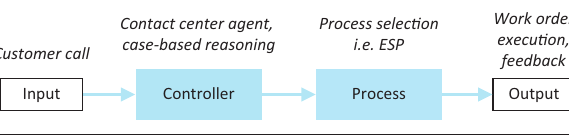
FIGURE 7: Open-loop transaction data